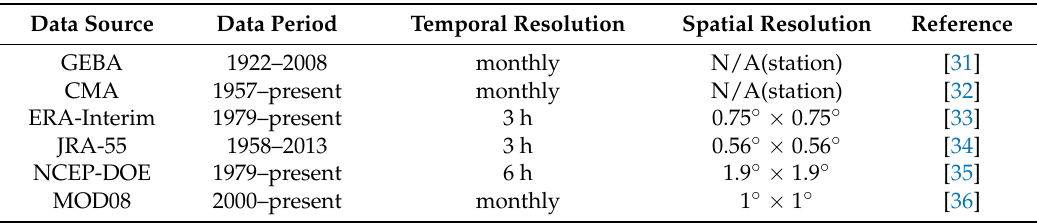
Table 1. Details of the data products used in this